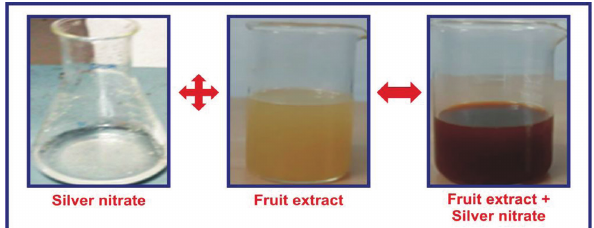
Figure 4: Synthesis of silver nanoparticles synthesis by Plum fruit